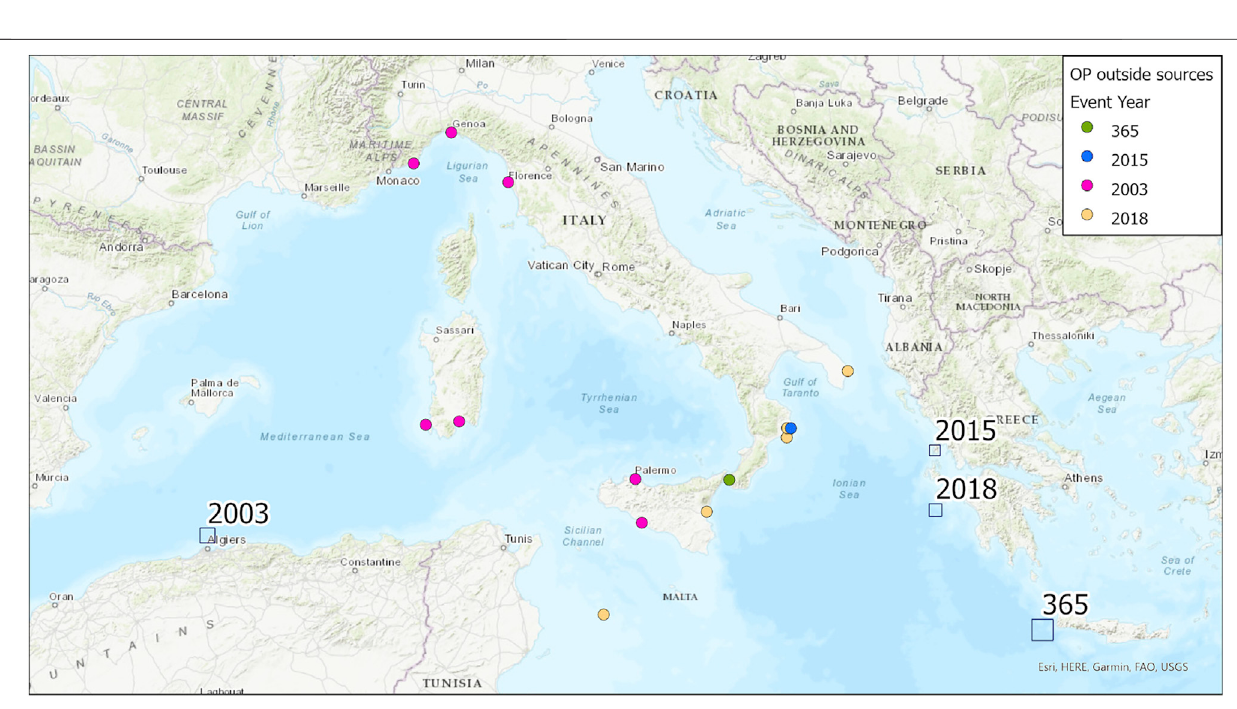
Frontiers in Earth Science |